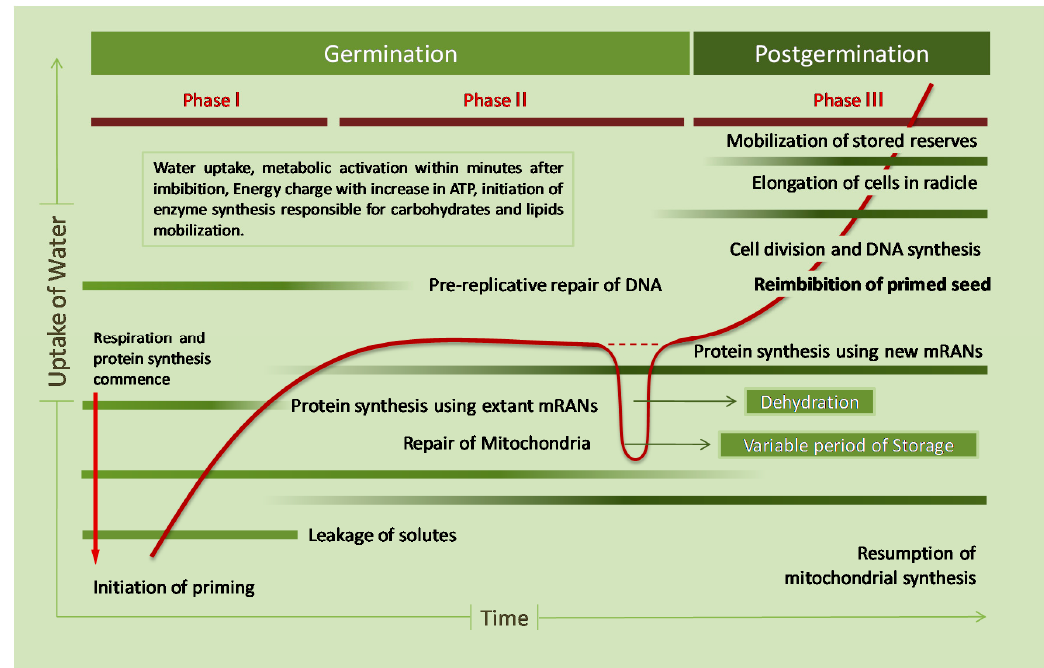
Figure 1. The physiological pattern in which priming could be e ff ective in metabolic phases of seed germination (modified from Bewley